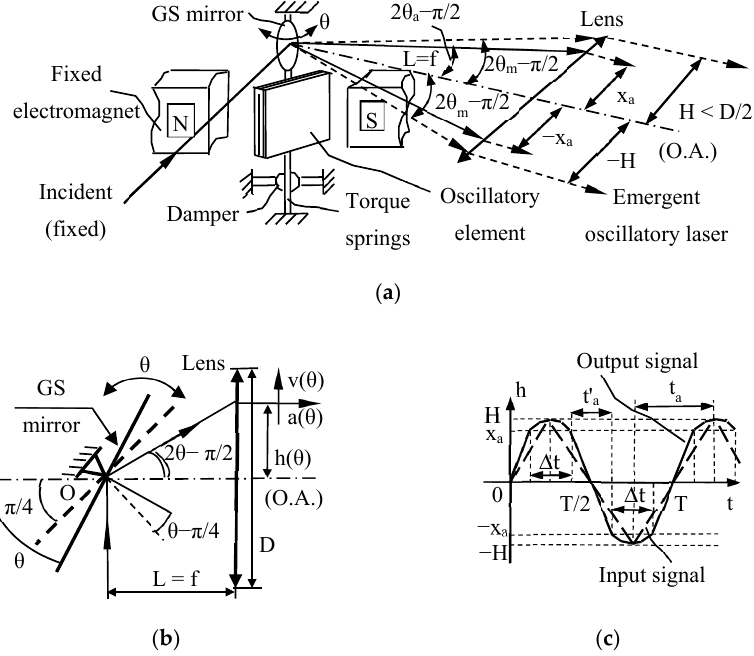
Figure 1. Galvanometer scanner (GS): ( a ) Principle scheme and main components; ( b ) beam deflection and corresponding angles and functions; ( c ) a common triangular signal of a GS, with a comparison between input and output (the latter given by the angular position of the GS mirror).